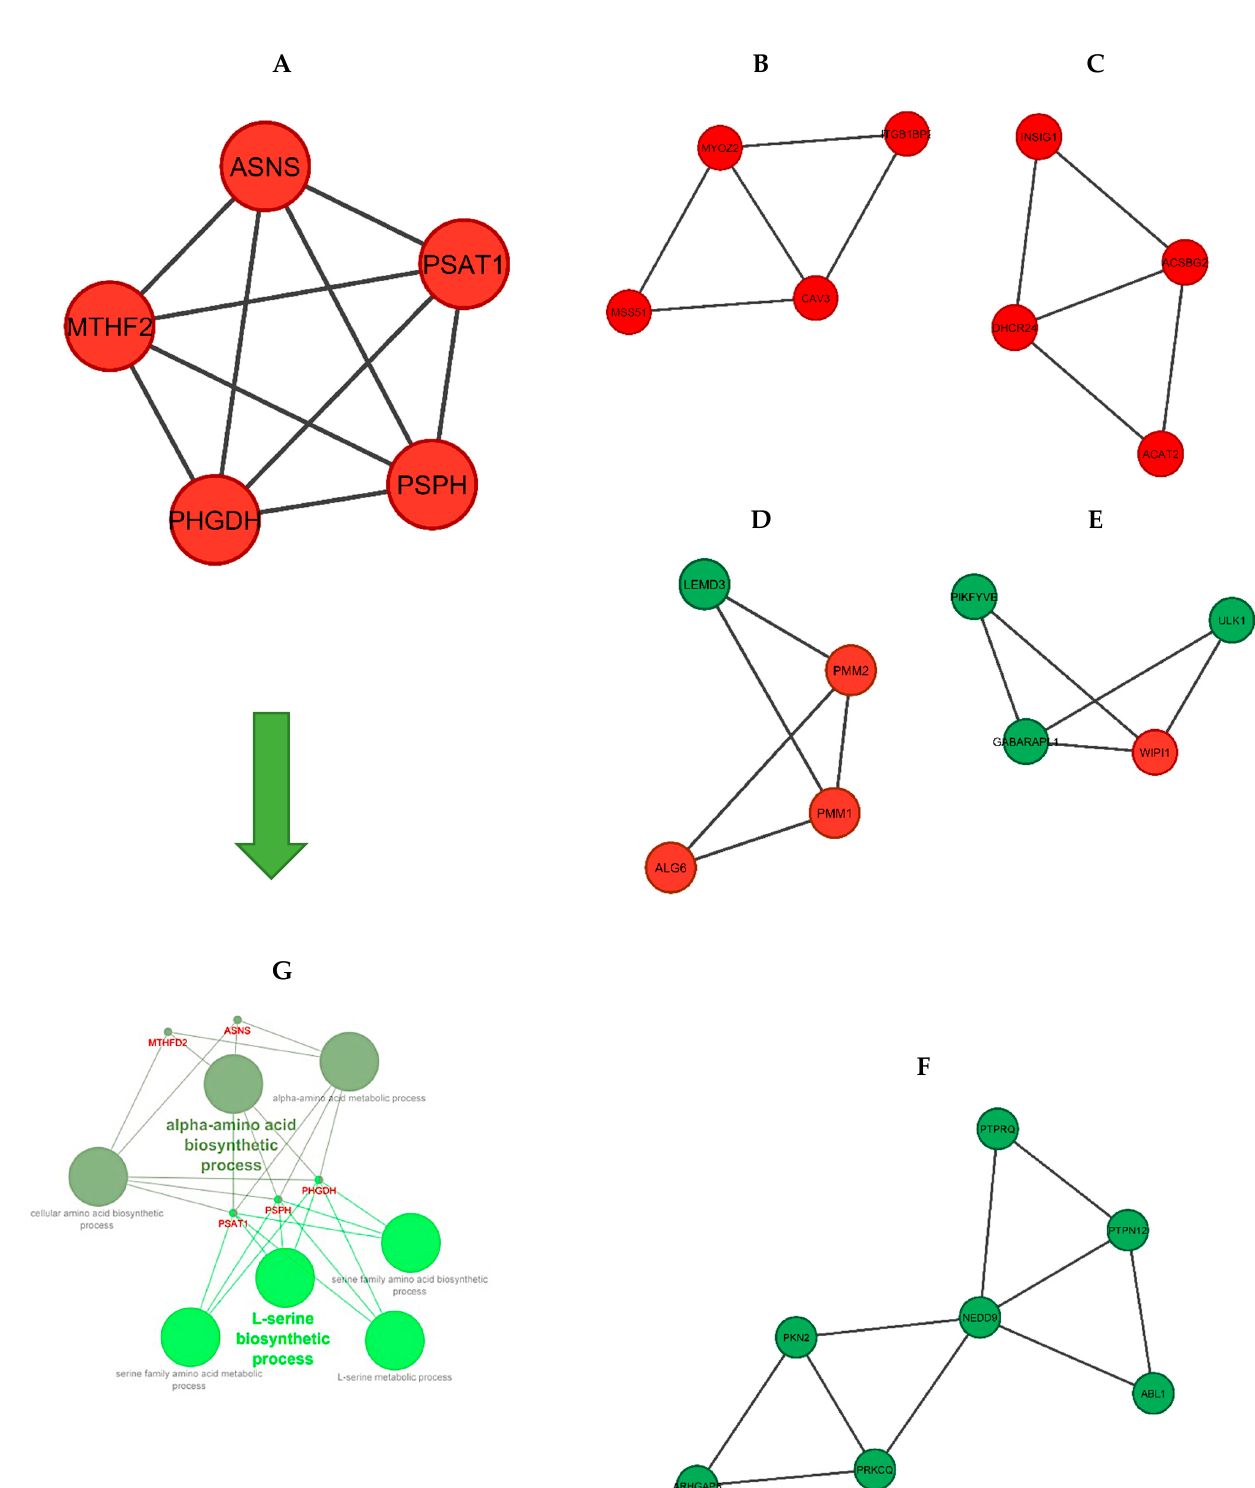
Figure 6. The significant modules of the DEGs PPI network. ( A – F ): Modules 1–6. (red nodes: up-regulated genes, green nodes: down-regulated genes). ( G ): Functional enrichment analysis of module 1. The two green spectra represent two different gene ontologies in which the genes of this module are involved (L-serine biosynthetic process and alpha-amino acid biosynthetic process).